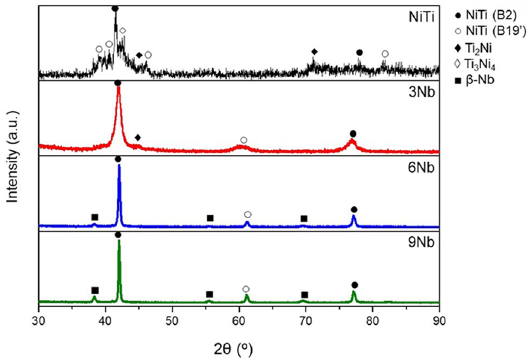
Figure 4. XRD spectra of the alloys NiTi and NiTiNb with different amounts of Nb.